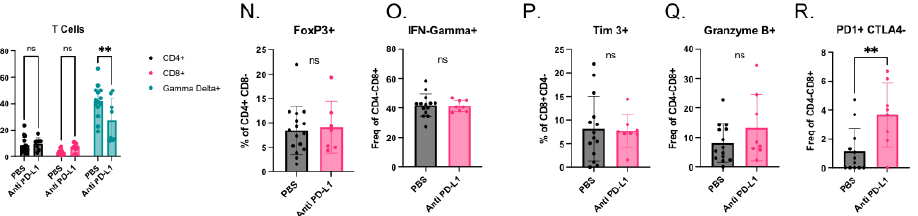
Figure 5. Response of subcutaneous and intraperitoneal STOSE.M1 luc models to